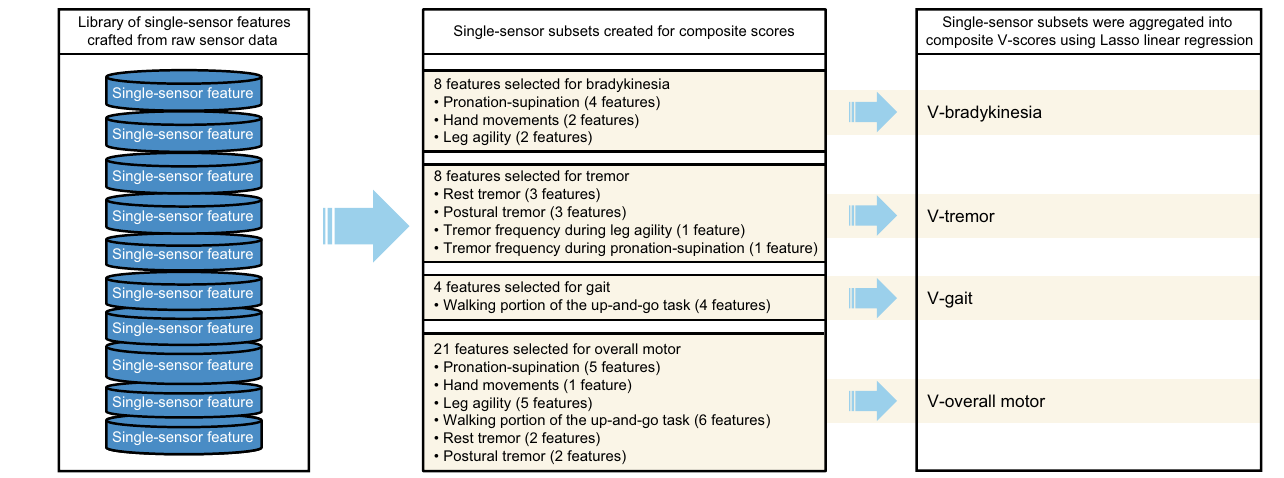
Figure 7. Development of composite V-scores from single-sensor–derived features. V-score machine-learned composite sensor scores for each motor